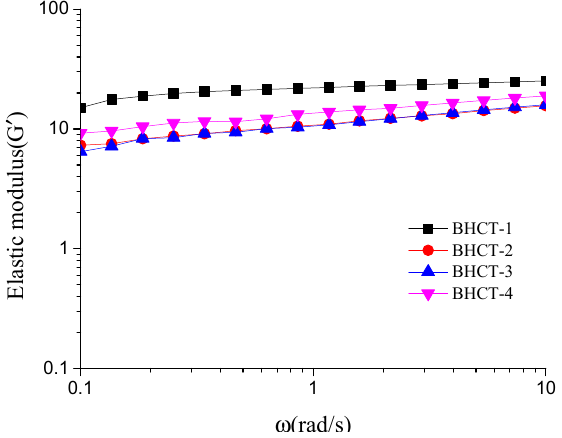
Figure 14. Elastic modulus of composite gel with different crosslinker contents.